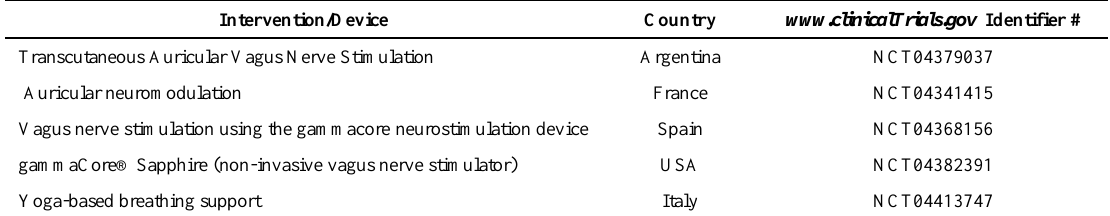
Table 1. Registered clinical trials using VNS to treat COVID-19 patients Intervention/Device